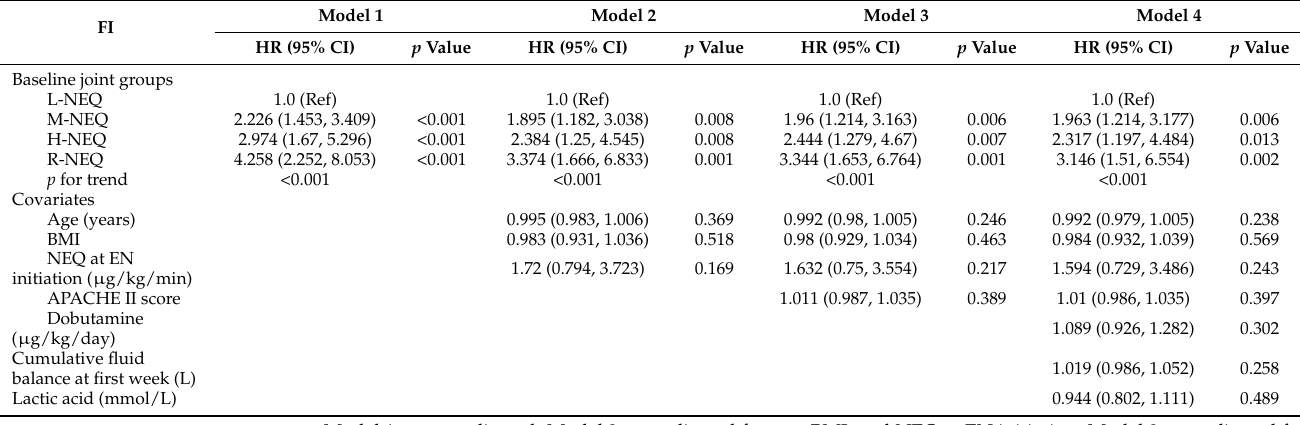
Table 3. Cox proportional hazard regression analysis of the effect of NEQ trajectory groups on FI.